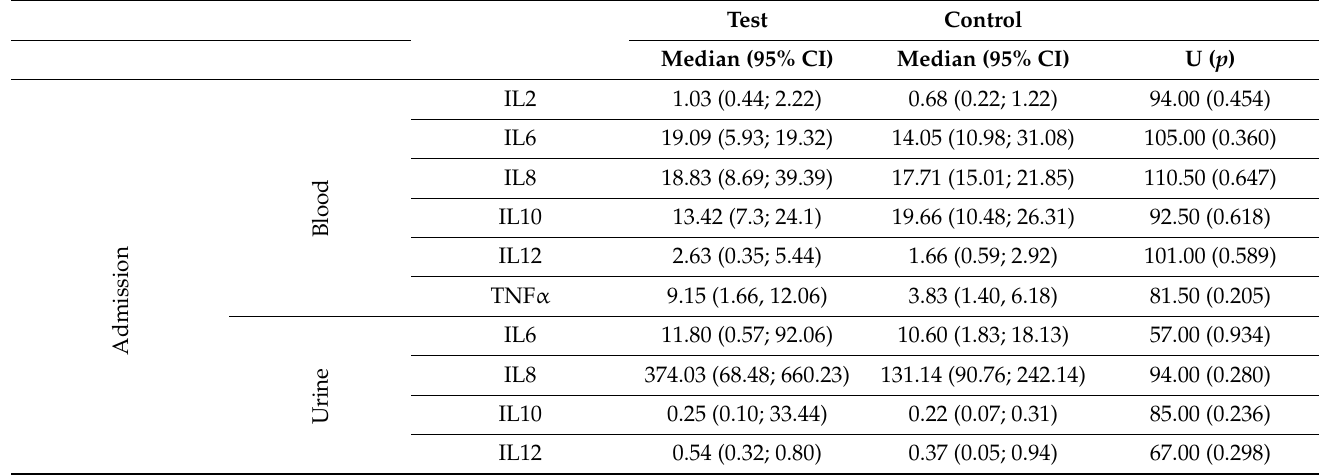
Table A1. Interleukins measured in blood and urine samples upon admission to the hospital, discharge, and after 6 months in the case and the control group (all values in